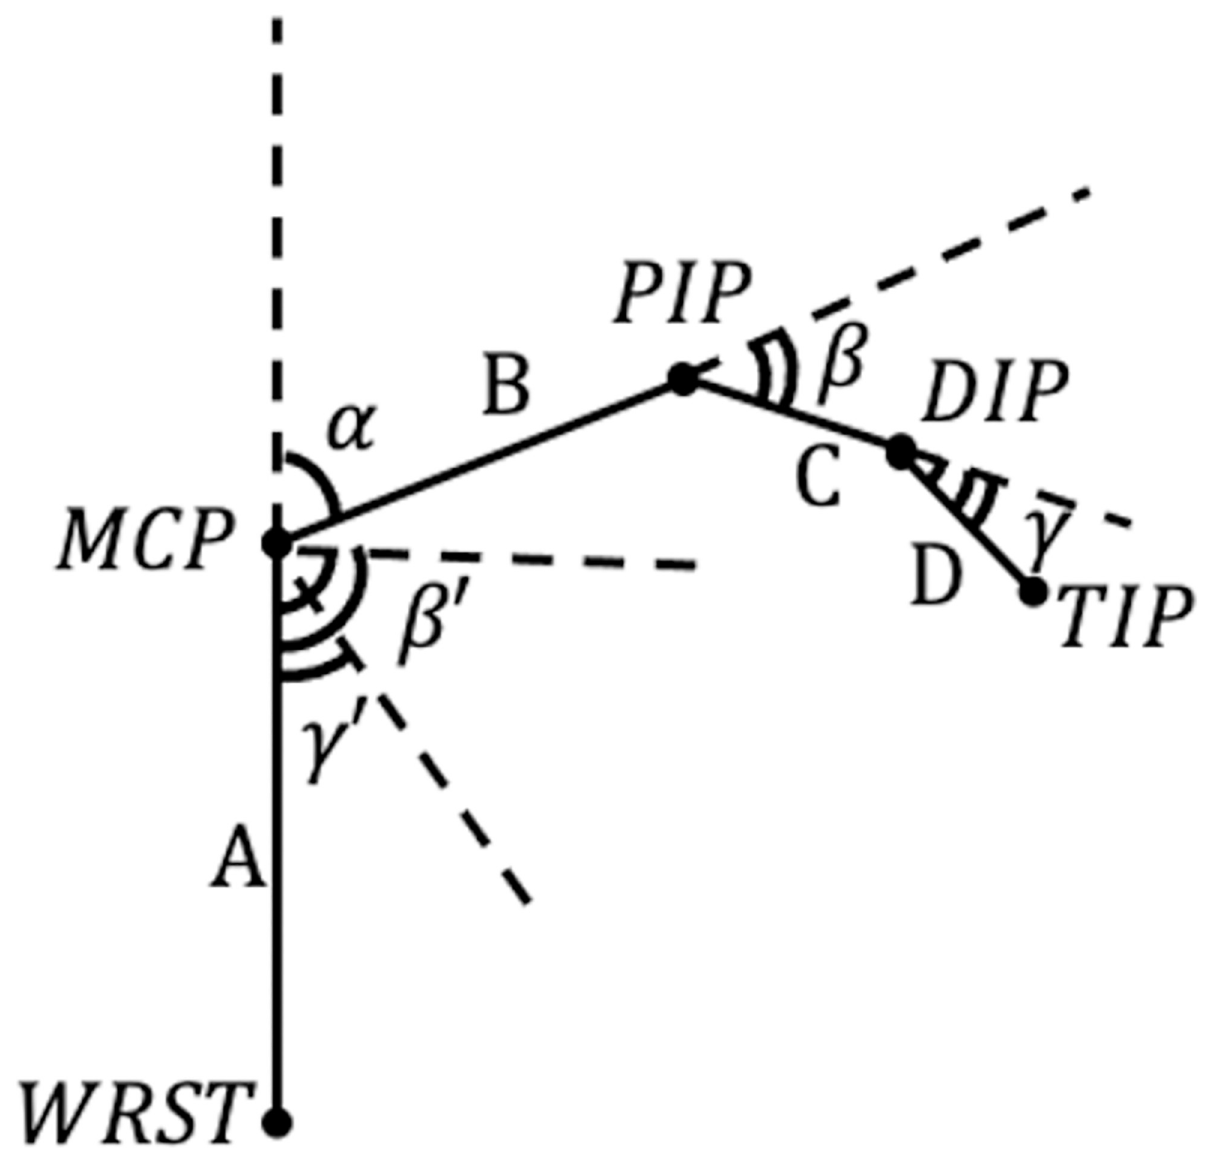
Fig 7. Geometric representation of the finger. Illustration of a geometric representation of the finger, where WRST indicates the wrist, MCP indicates the metacarpophalangeal joint, PIP indicates the proximal interphalangeal joint, and DIP indicates the distal interphalangeal. α represents the included angle of the metacarpophalangeal joint, β represents the included angle of the proximal interphalangeal joints, and γ represents the included angle of the distal interphalangeal